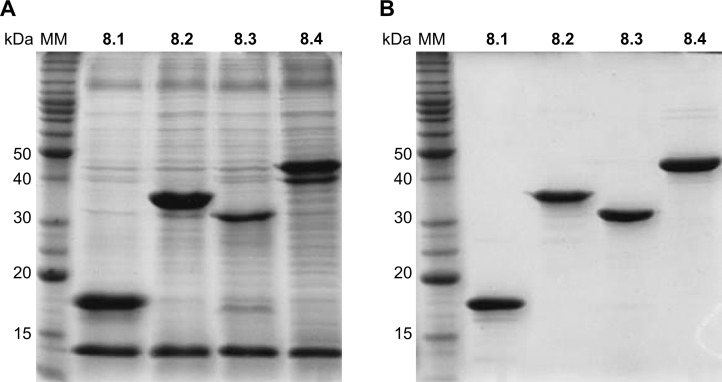
SDS-polyacrylamide gel stained with Coomassie Brilliant Blue G-250.IBMP chimeric proteins were purified from the total protein extracts (A) and 1.5 μg of each pure recombinant antigen were applied per lane (B). MM: molecular weight marker. IBMP-8.1 (17 kDa); IBMP-8.2 (36 kDa); IBMP-8.3 (30 kDa); IBMP-8.4 (45 kDa).